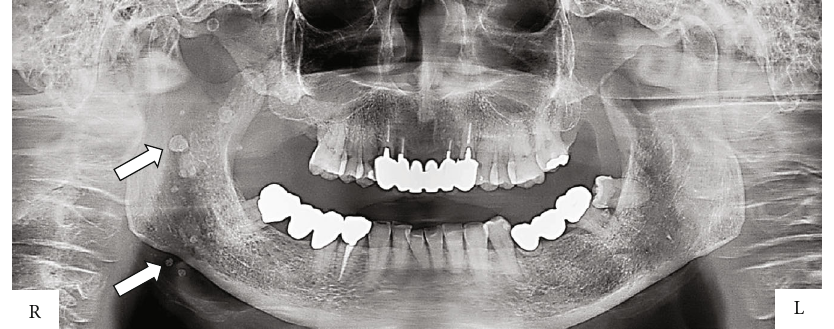
Figure 3: A panoramic radiograph during initial examination. Scattered opaque material suspected to be venous stones is noted. A circular opacity is evident (arrow).